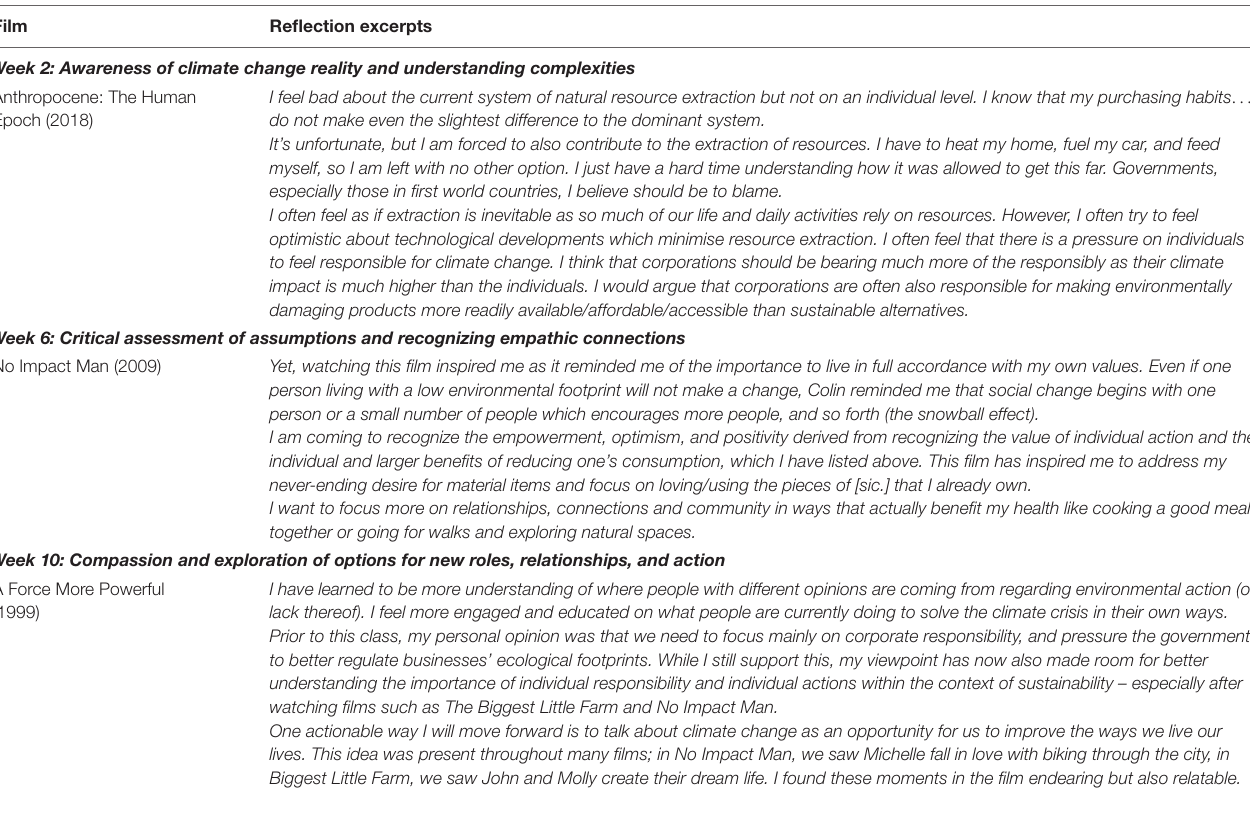
TABLE 5 | Select quotes from Week 2, 6, and 10 reflections that exemplify the journey of transformative learning from awareness of context and reality to exploration of options for new roles, relationships, and action (phase 5 of the transformative learning